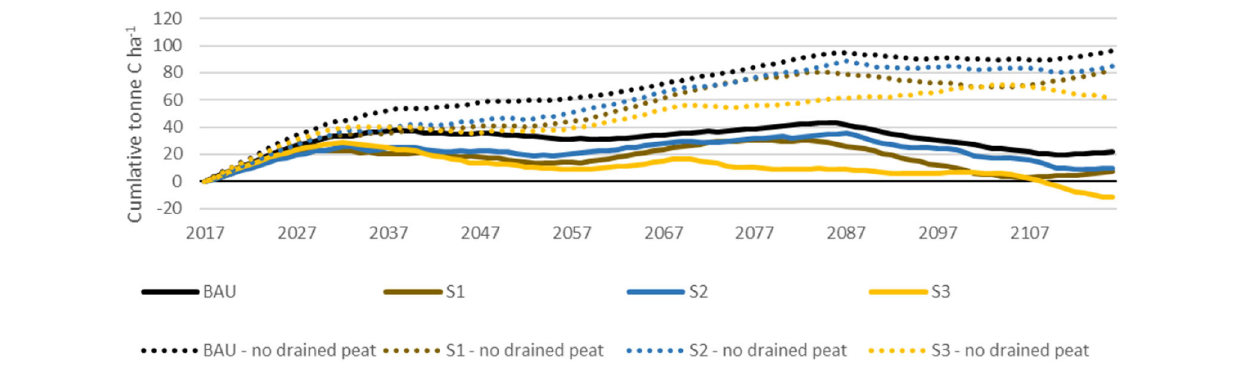
ha, 3,613 ha, and 2,456 ha in 2116 for BAU, S1, S2, and